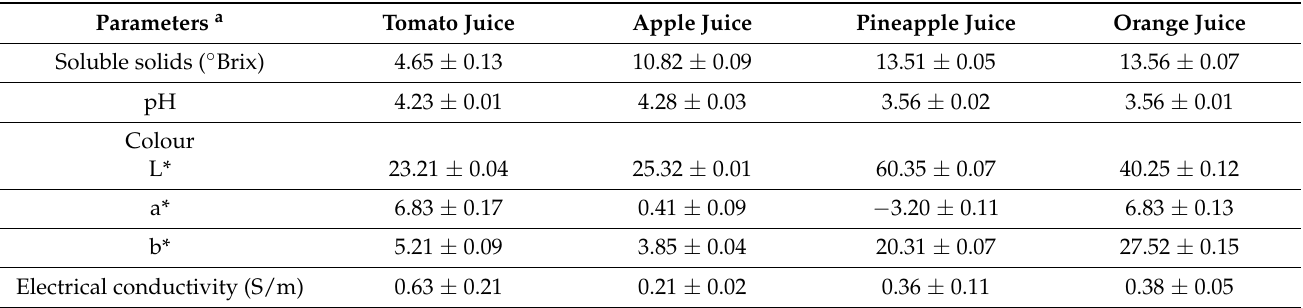
Table 1. Analytical characteristics of